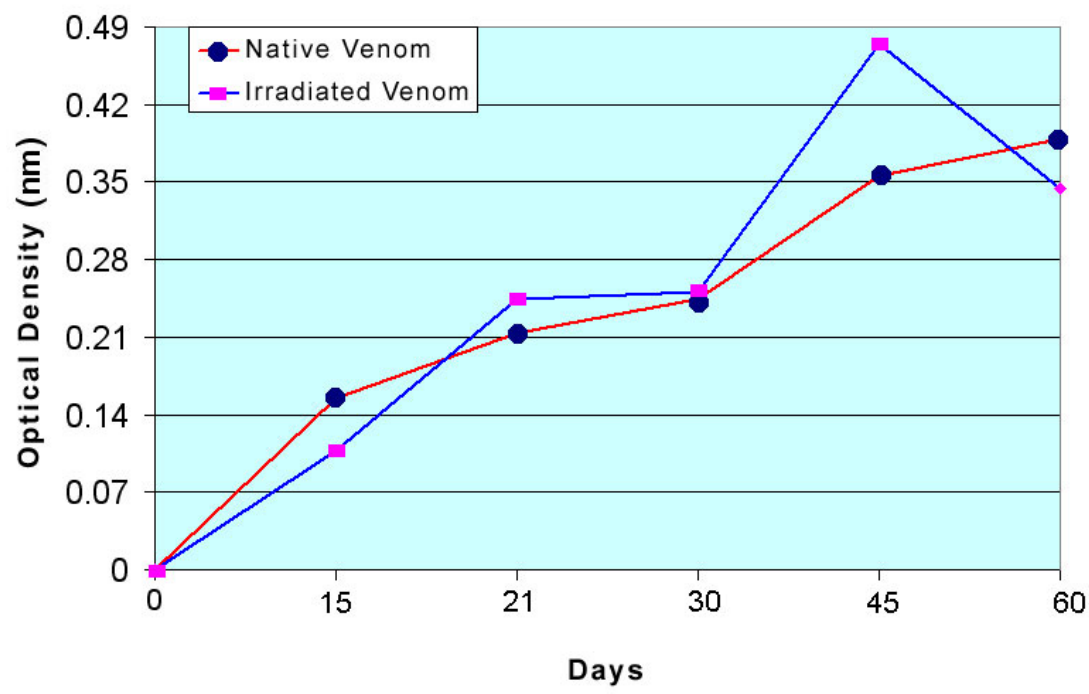
Figure 2: Distribution of the optical densities mean values in different moments, using serum from animals inoculated with Bothrops jararacussu venom, native (GIII) and 60 Co-irradiated (GIV), diluted in 1:200. G III = G IV; F = 2.81 < F = 7.71 ( α = 5 %). Lines critical x D x D x D x D x D ; F = 18.01 > F = 6,39 ( α = 5 D 0 15 21 30 45 60 Columns critical